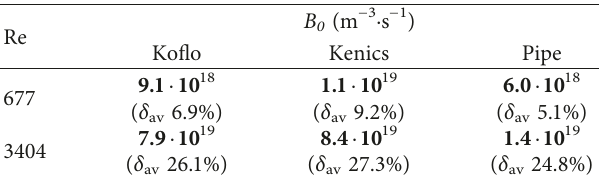
Table 6: The relation between Reynolds number and the nucleation rate B 0